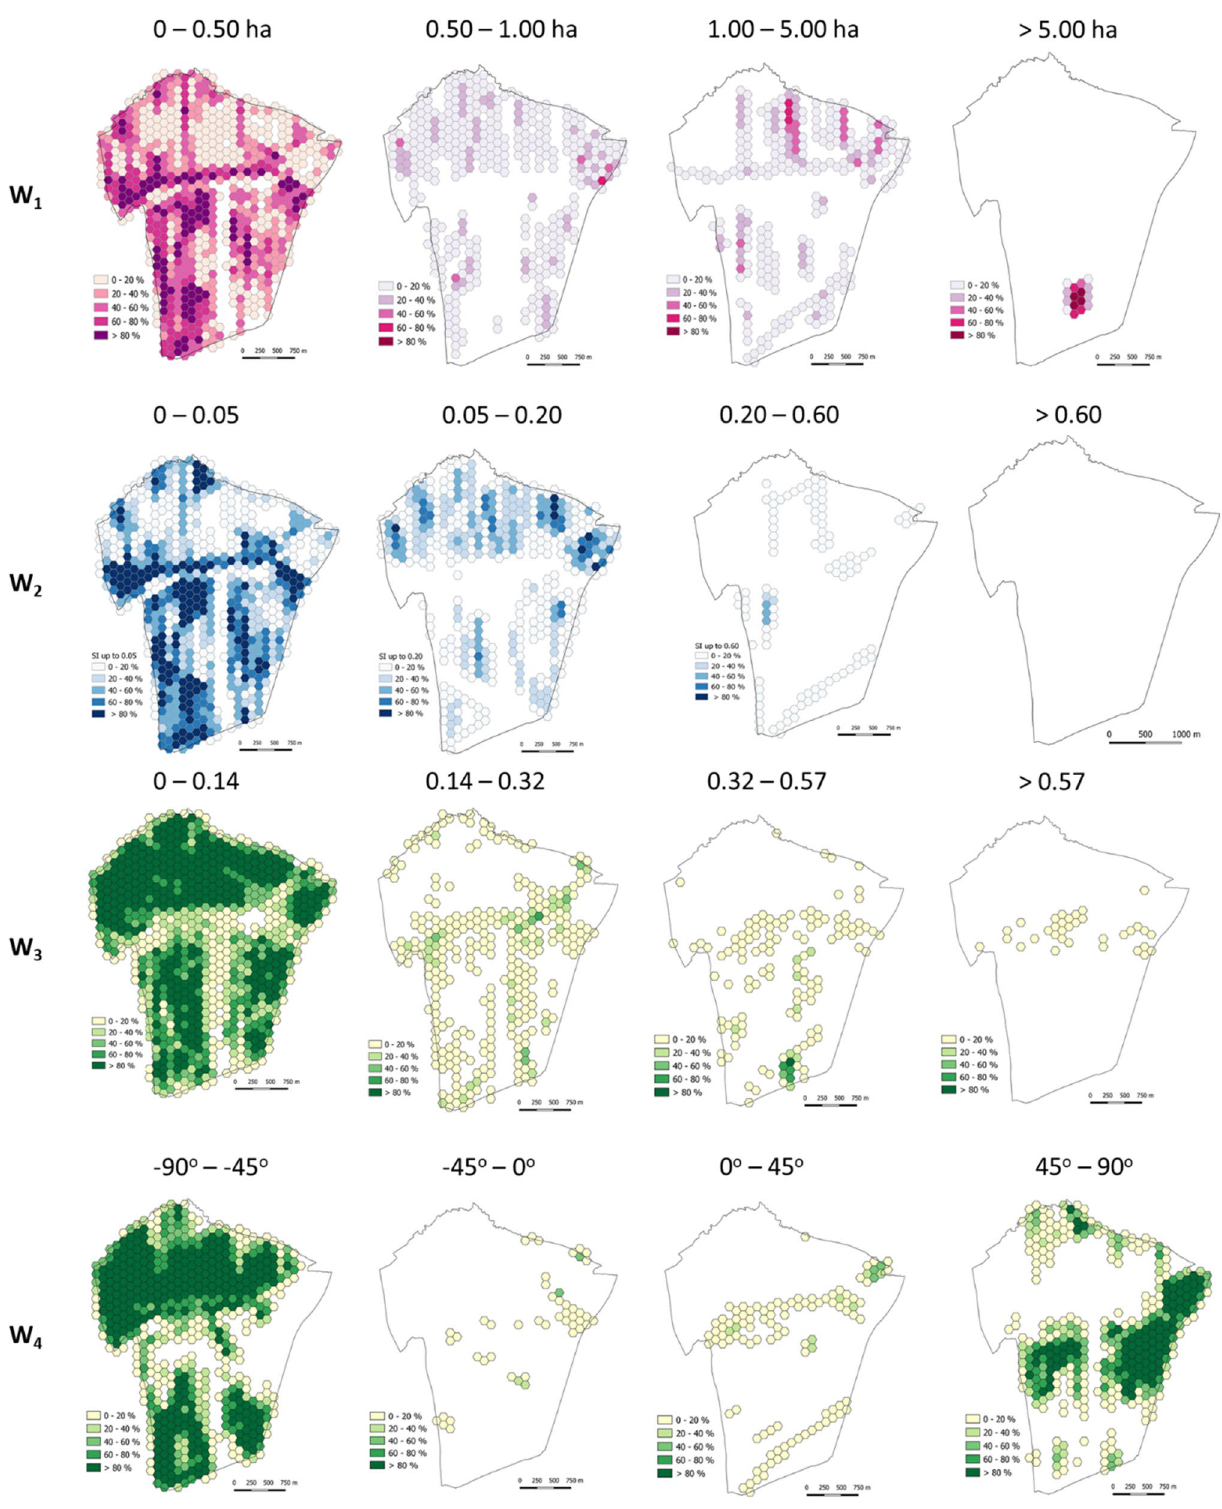
Figure 6. The variation in component indices by variable